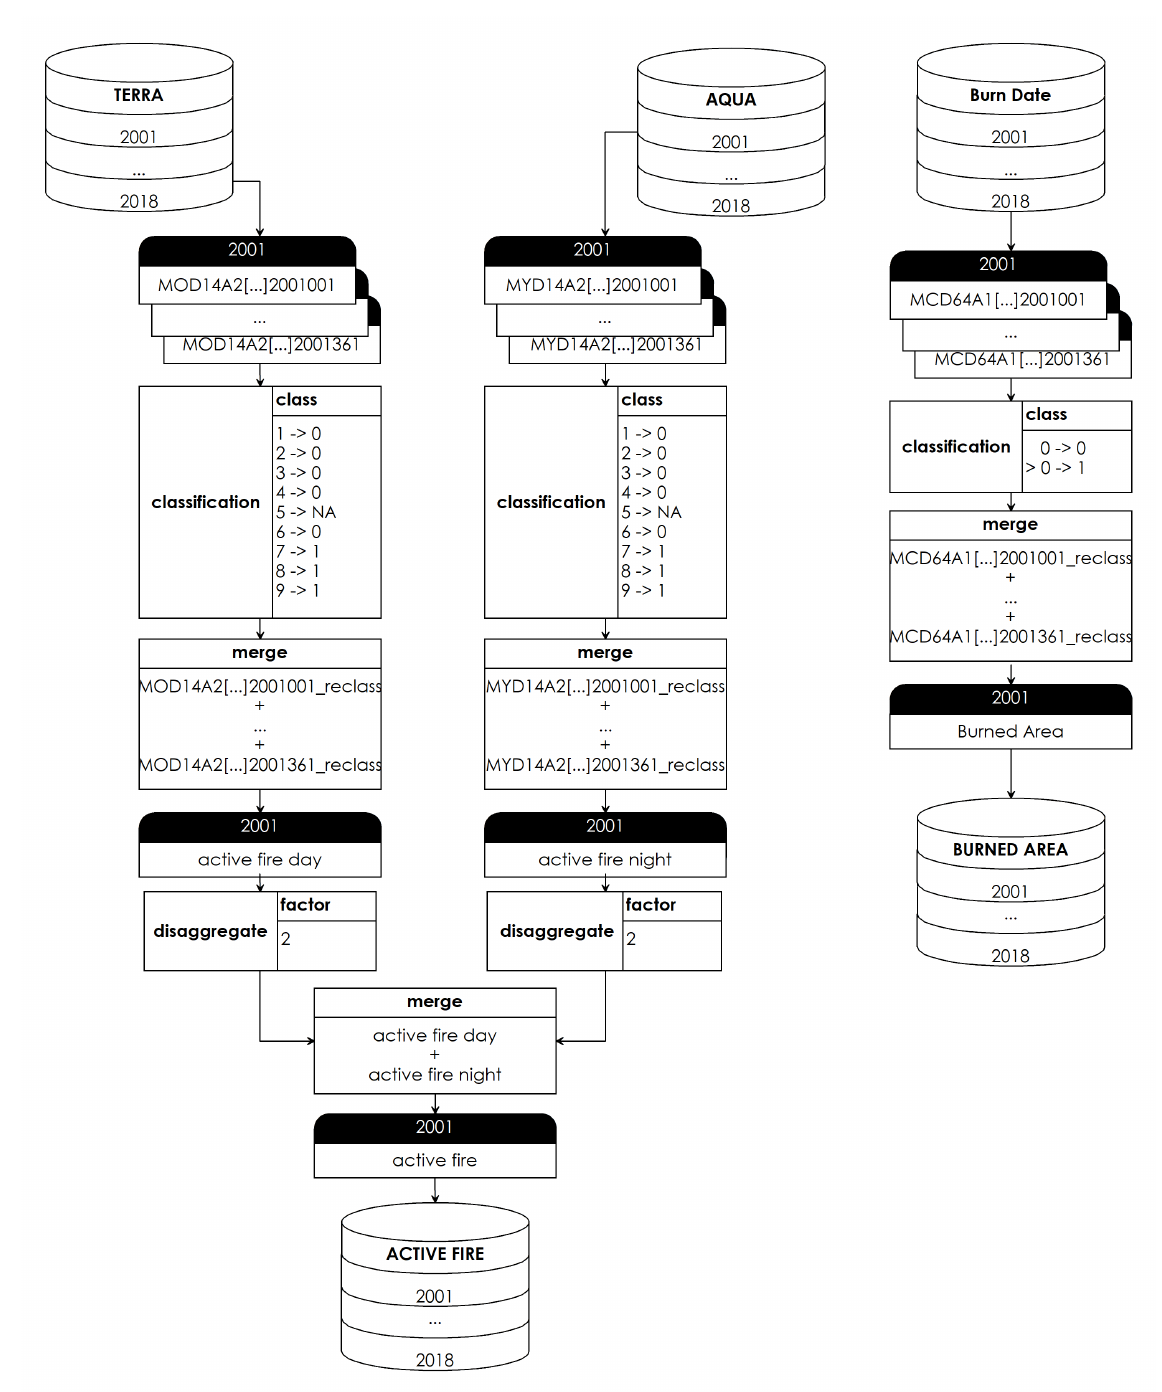
Figure A1. Pre-processing of MODIS active fire and burned area